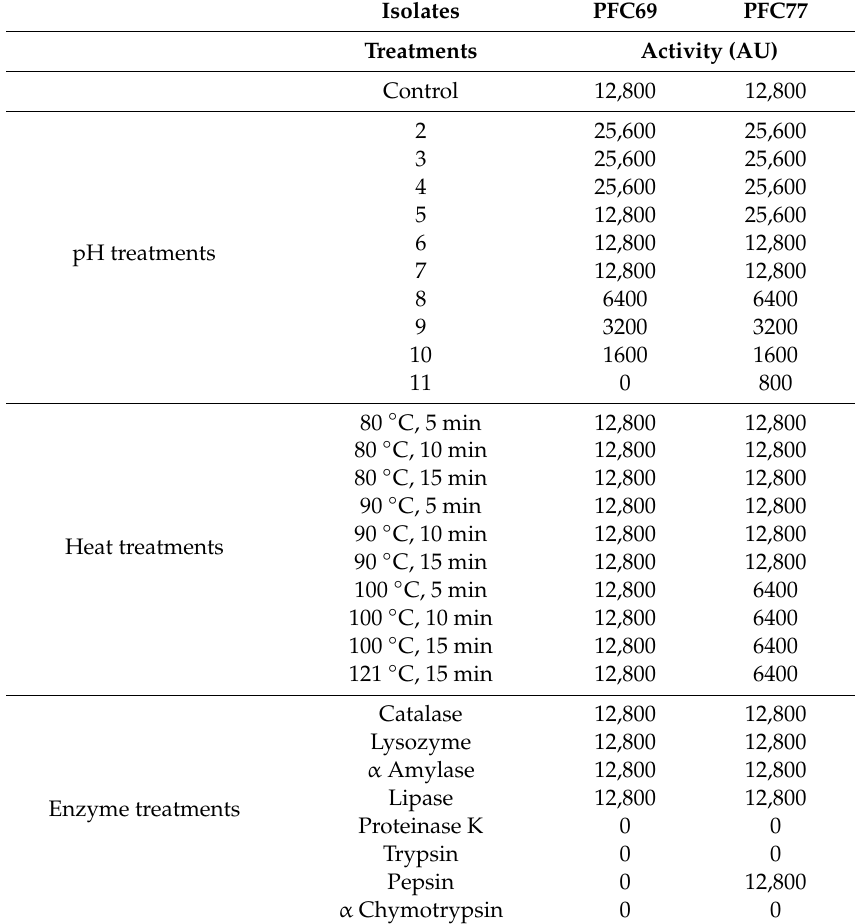
Table 2. The pH, heat, and enzyme sensitivity characteristics of bacteriocin-like substances (BLS) produced by P. acidilactici PFC69 and L. lactis